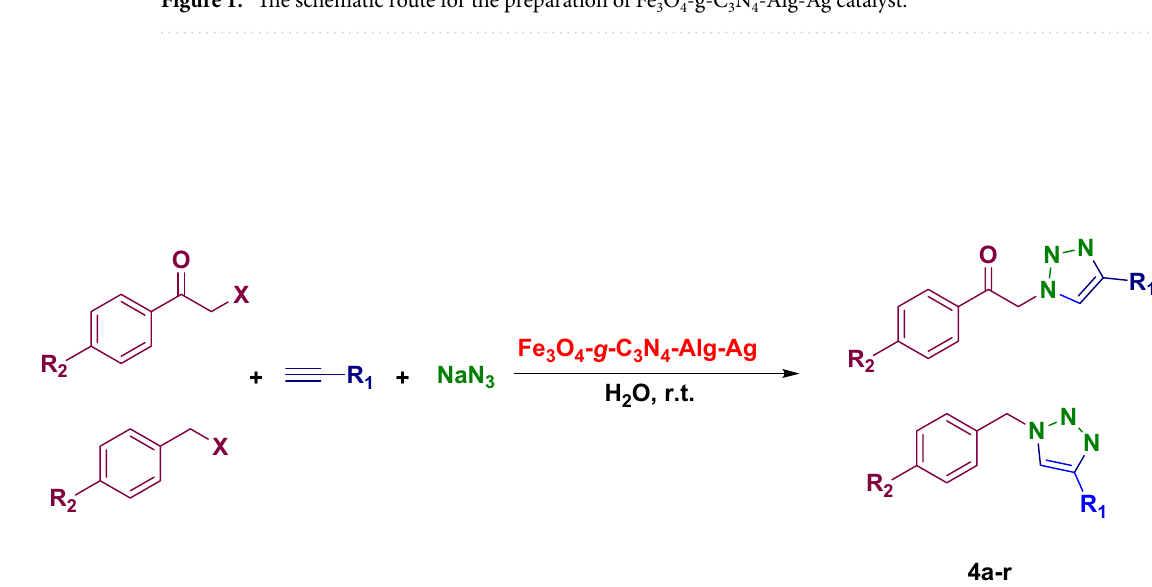
Figure 1. The schematic route for the preparation of Fe 3 O 4 -g-C 3 N 4 -Alg-Ag catalyst.